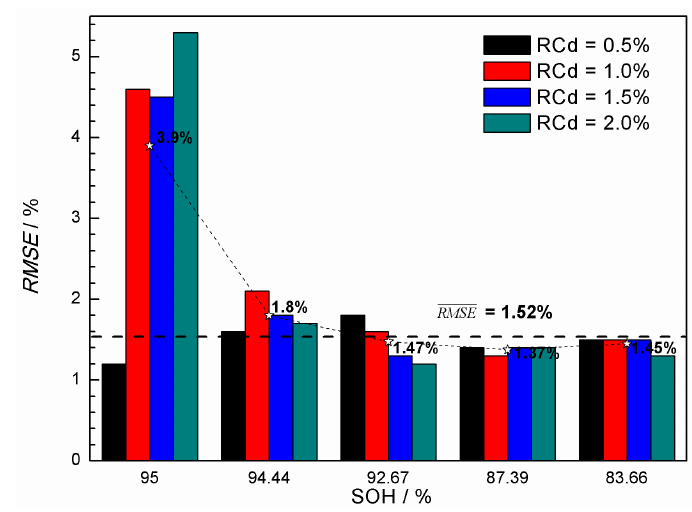
Figure 9. Prediction RMSE for a Ni-MH battery in the charge-discharge test at 1.6C using ( C discharge , Δ V charge ) data groups at different SOH with various RCds.